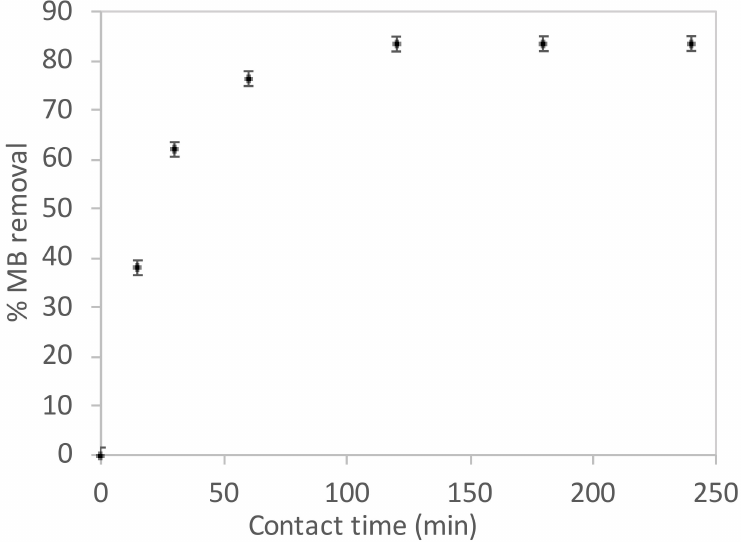
Figure 9. Adsorption time effect on the %MB removal (1.000 g of biomass, 100 mL of solution with 50 ppm of MB, pH = 6.0, system was stirring at 150 rpm at 289